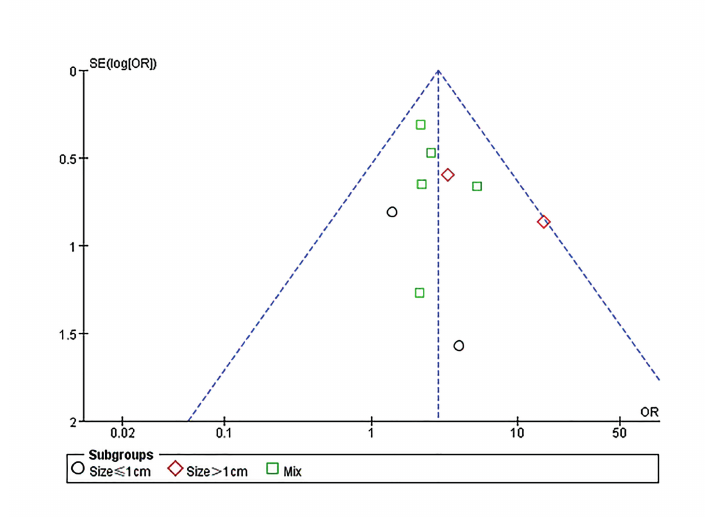
Supplementary Figure 3- Funnel plot with stone clearance as the outcome according to the size of